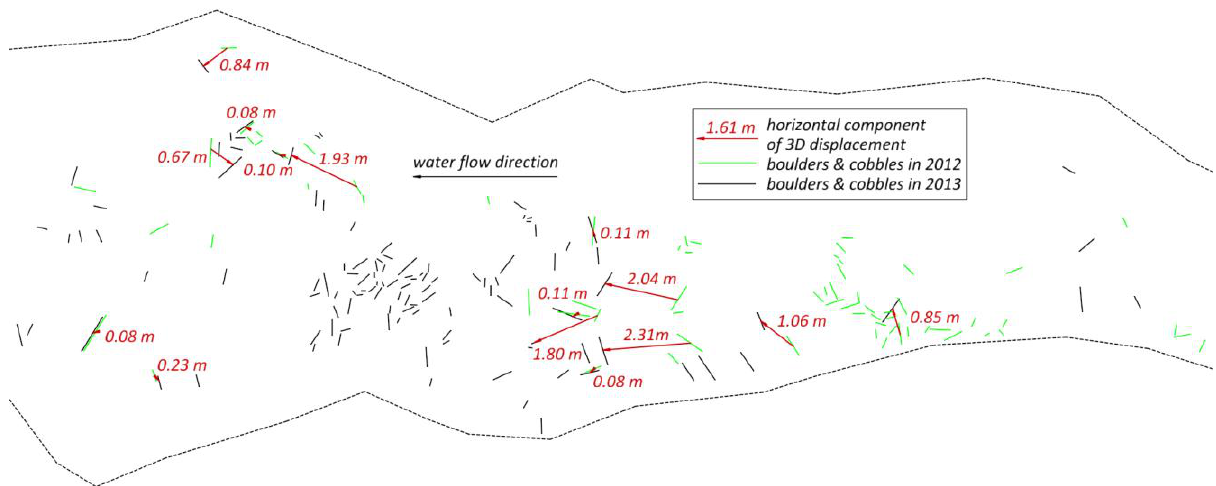
Figure 8. Horizontal displacements and map of moved boulders and cobbles for years